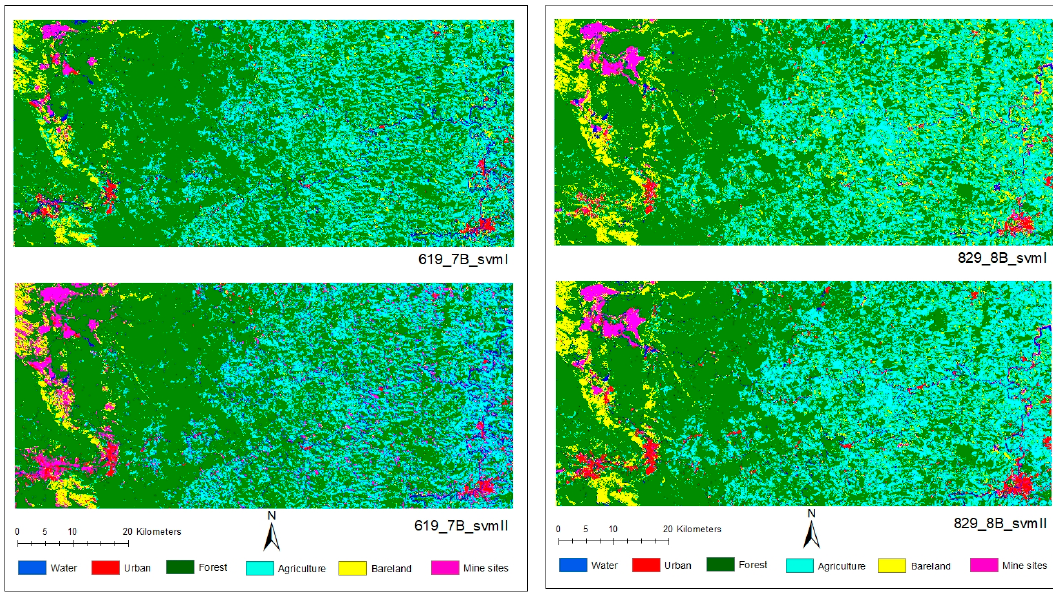
Figure 4. Classification method I and II with 2000 and 2017 images used dataset (B) with SVM